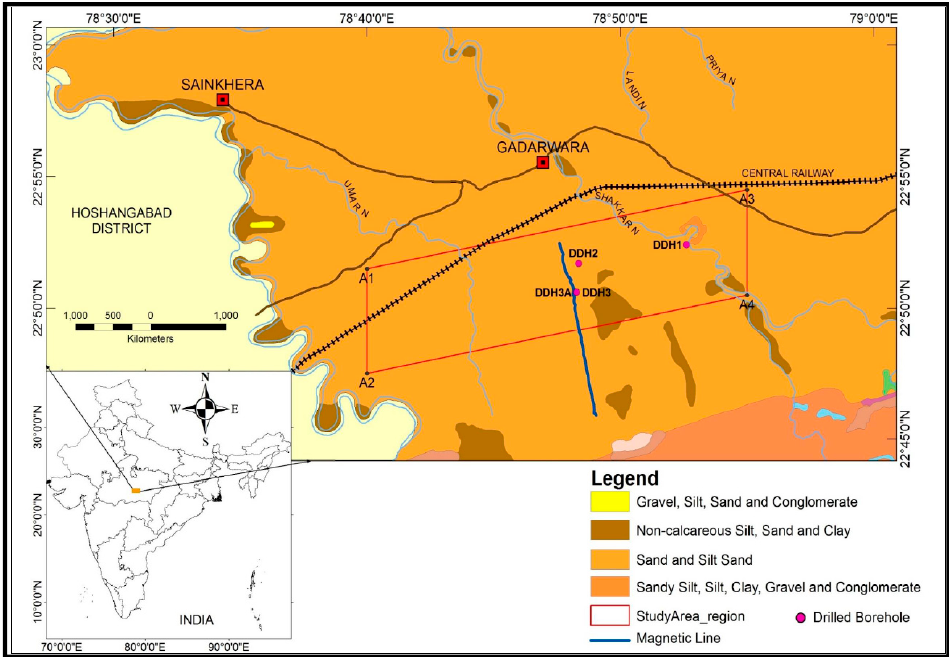
Figure 3. Study area boundaries.